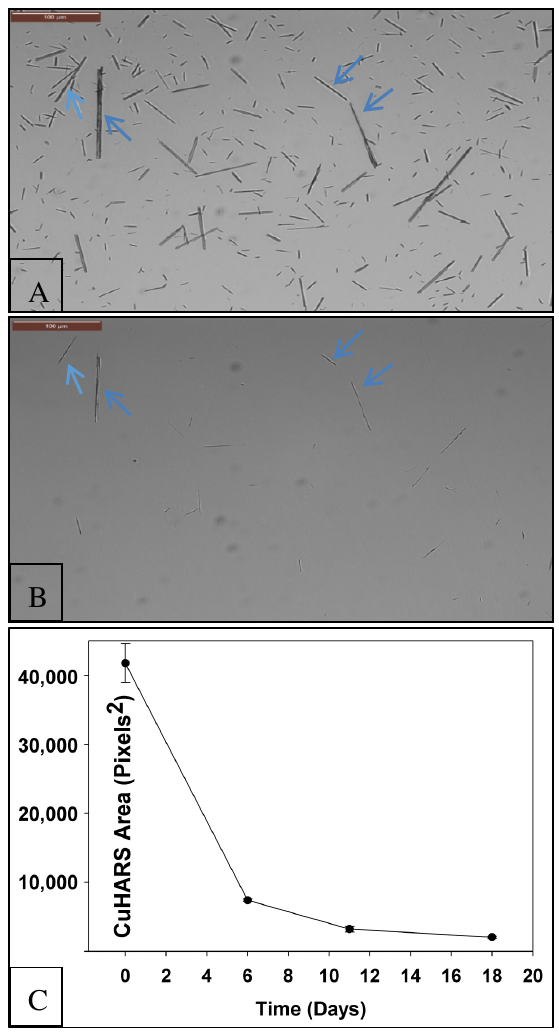
Figure 3. Passive breakdown of CuHARS under physiological conditions. CuHARS at 25 µg/mL was placed in complete microglial cell media (see methods), but with no cells present. Panel ( A ) shows CuHARS area coverages after 1 day in vitro, and in Panel ( B ), near complete breakdown of materials after 18 days. The two panels shown are the same area tracked over 18 days. Only the largest CuHARS remain after this time (arrows). Scale bar in upper left indicates 100 microns. Monochrome images are shown here to enhance the contrast of the highly degraded (thin) CuHARS. Panel ( C ): digital images of CuHARS at 25 µg/mL starting concentration (day 0) were obtained in 4 different neuronal cell culture media (see Section 2), and the area of CuHARS quantified at days 0, 6, 11, and 18, as indicated. Data shown are the averages of fields tracked in 4 different culture media over 18 days, with standard error of the mean shown.